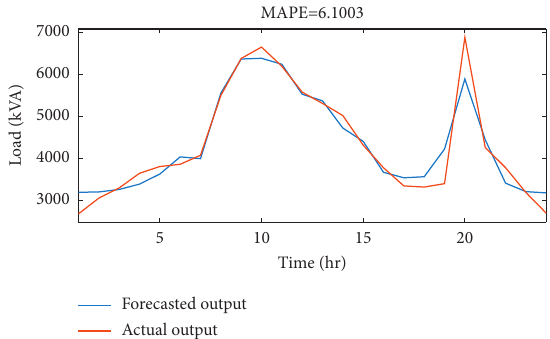
Figure 20: The Fuzzy-PSO prediction of New Year load.